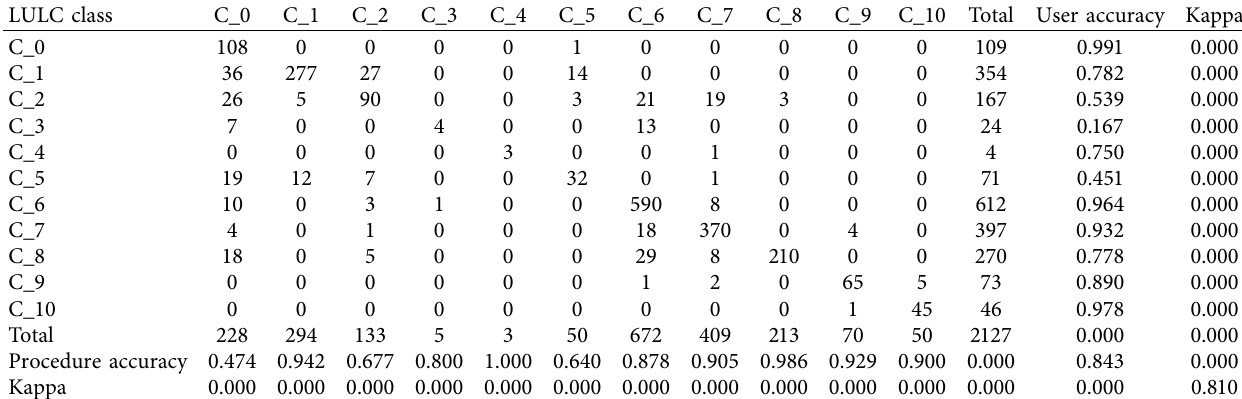
Table 7: Results of the accuracy assessment for the LULC classification based on the SVM classifier with the MaSegFil approach.